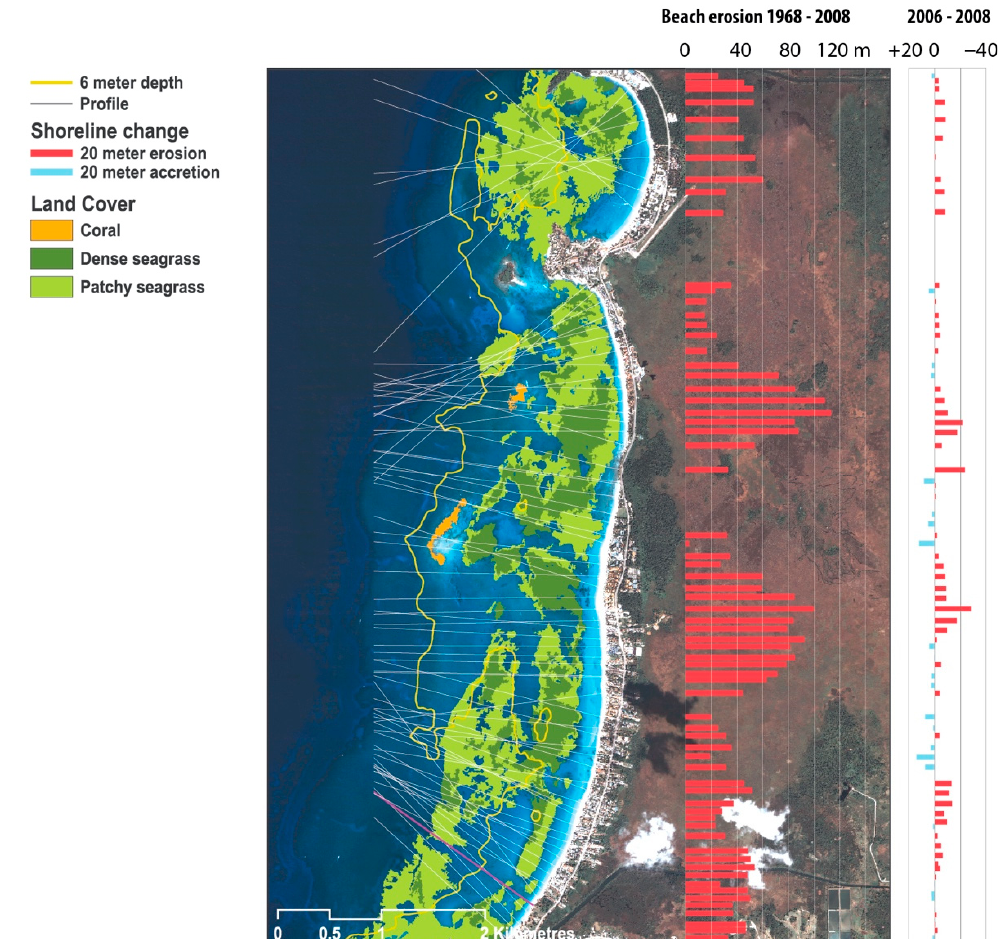
Figure 2. Over Quitckbird image (60 cm resolution taken 16 January 2008), distribution of nearshore ecosystems, location of the beach and seabed profiles considered, and rates of beach erosion. Location of the profile modelled and perpendicular lines are shown (in white). Long-term trends (in red) for 1968–2006 and short-term (2006–2008) in blue for accretion and red for erosion.